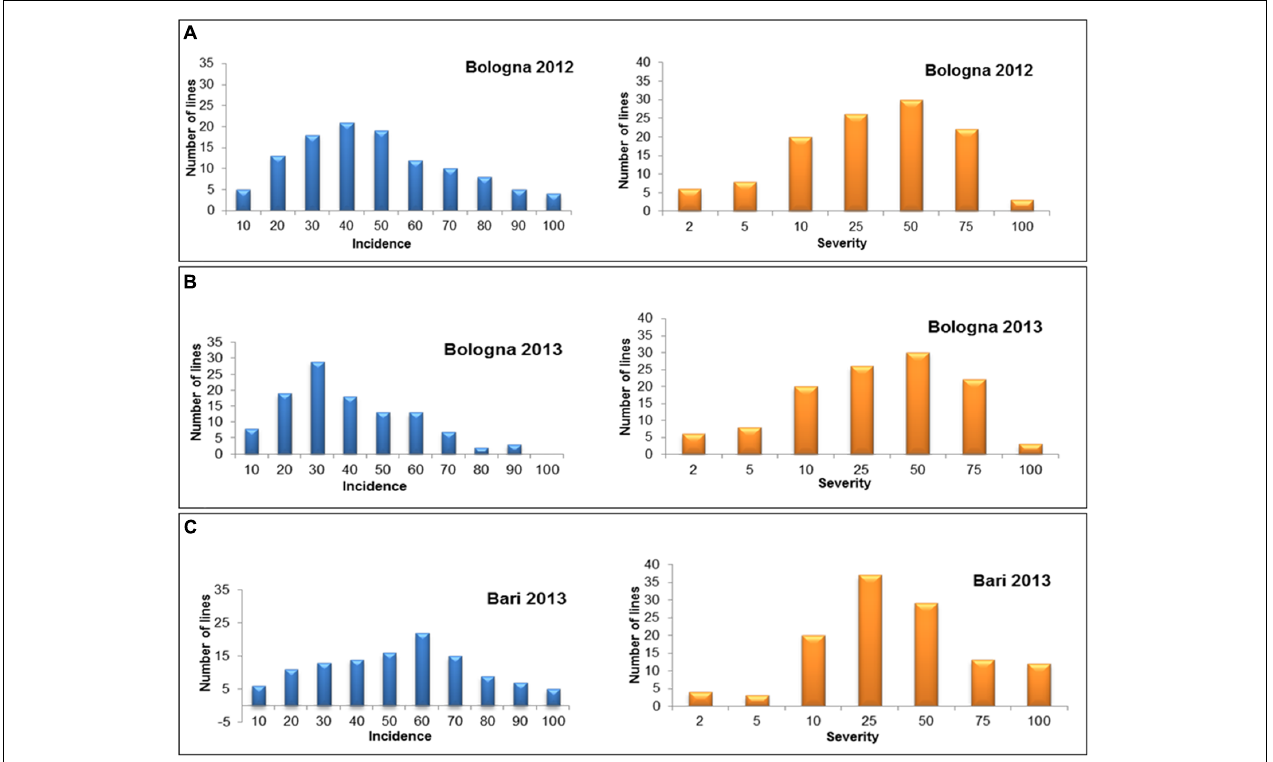
FIGURE 2 | Diagrammatic representation of frequency distribution for FHB incidence and severity in the RIL population derived from crossing the resistant 02-5B-318 line and the susceptible cv. Saragolla in the three environments of Bologna 2012 (BO12) (A), Bologna 2013 (BO13) (B), and Bari 2013 (BA13)